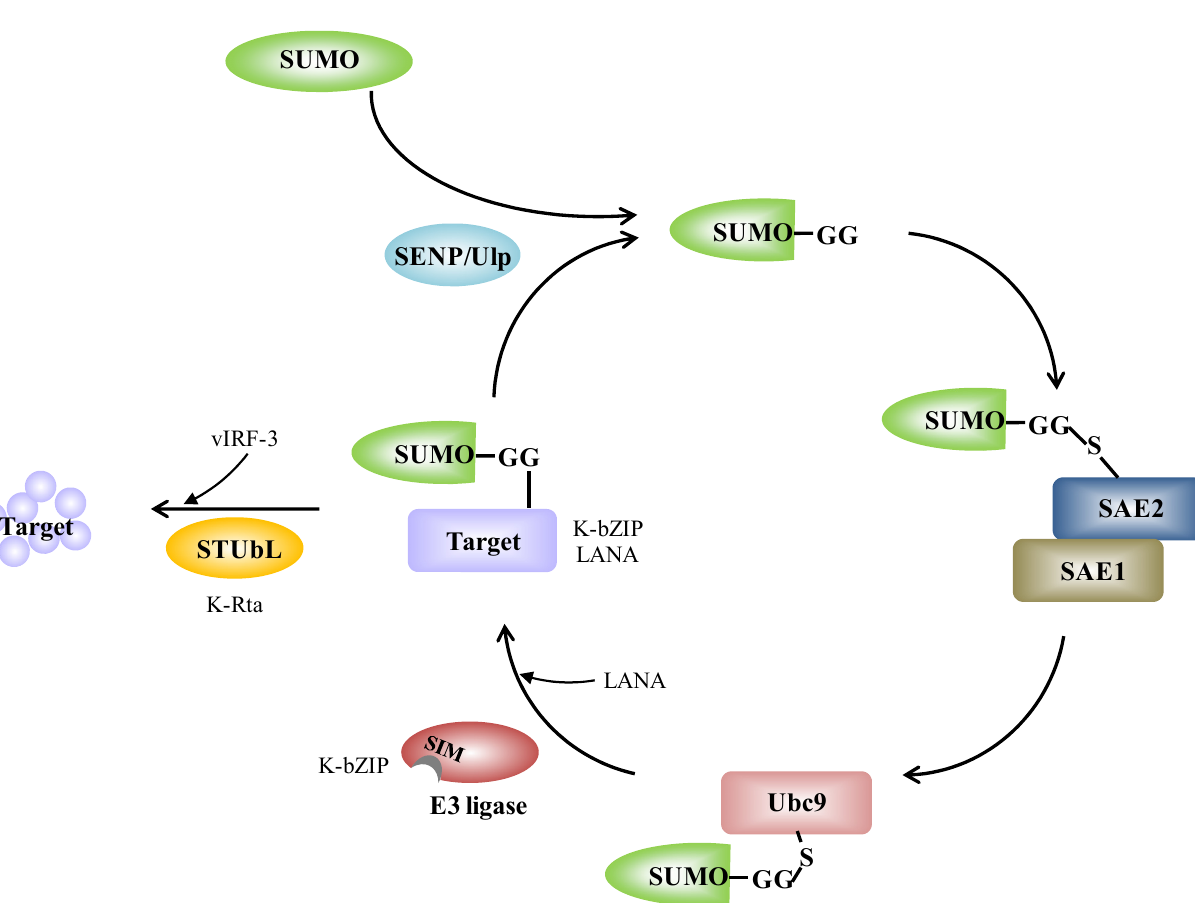
Figure 1. The SUMO conjugation enzyme cascade pathway and its links with KSHV. SUMO precursors are cleaved at the c-terminus by SENP and this reveals a GG motif. Mature SUMO is activated by conjugation to the SUMO E1 activating enzyme (SAE1/SAE2). Activated SUMO is transferred to the SUMO E2 conjugating enzyme (Ubc9). Ubc9 itself is able to catalyze SUMO conjugation to the lysine residue of a target proteins. SUMO E3 ligases are dispensable, but increase target specificity. SUMO is removed from the target by SENP, which cleaves SUMO from the substrate and releases free SUMO; alternatively, STUbL targets the sumoylated protein for degradation. The scheme also illustrates the proteins of KSHV and the corresponding components in SUMO modification system. K-bZIP itself is a SUMO E3 ligase and LANA acts as a SUMO E3 ligase. K-Rta itself is a STUbL and vIRF-3 acts as a STUbL. Detailed information is given in the